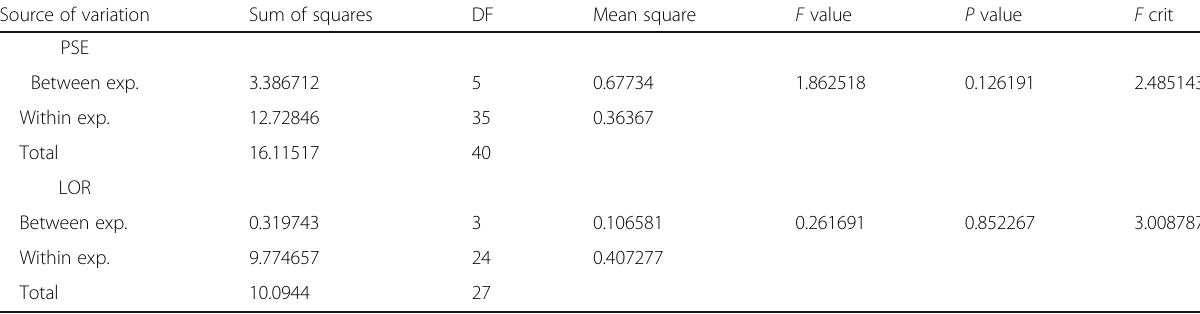
Table 5 ANOVA (single factor) for comparison of the results of the proposed spectrophotometric methods and those of the official methods for determination of PSE and LOR in pure powdered forms Source of variation Sum of